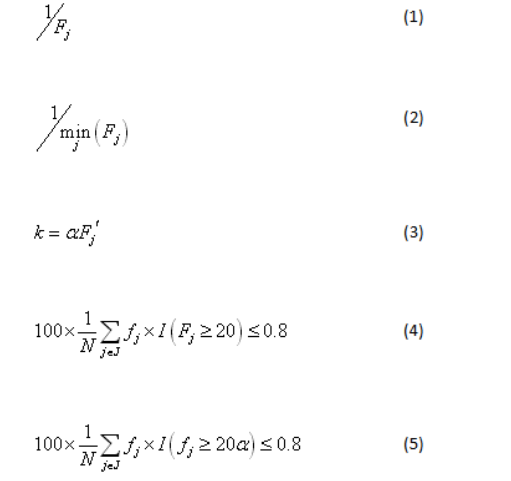
Figure 1. Equations describing how re-identification risk was